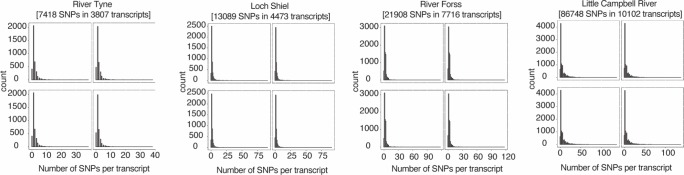
Number of informative (tested) SNPs per transcript per cross.Four panels per cross represent four analyzed F1s. Zero corresponds to positions where SNP position was not informative (expressed) in a given F1, but informative in other F1s of the same family.